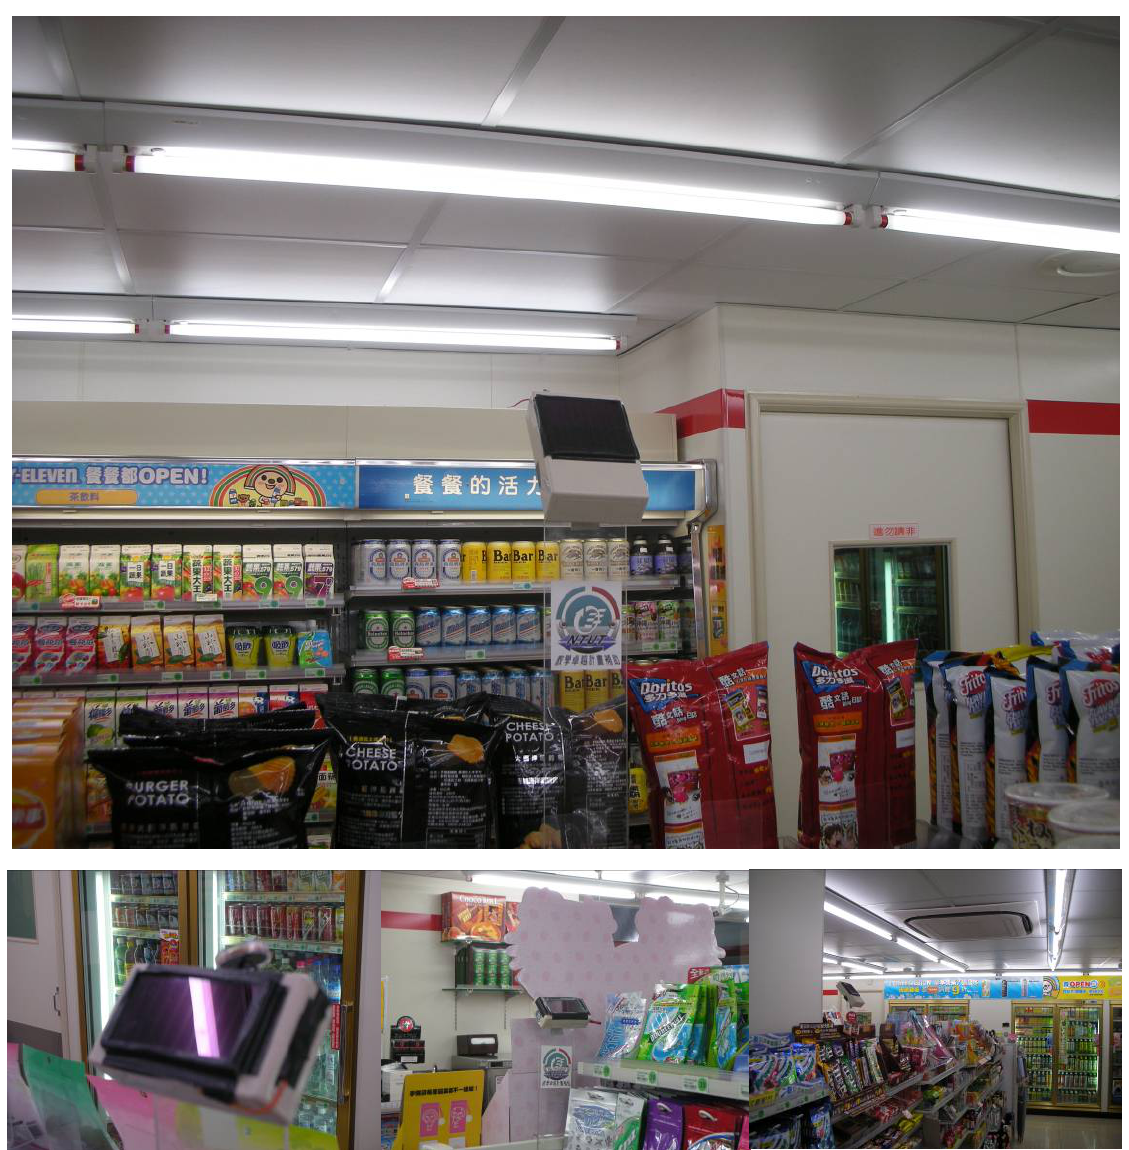
Figure 7. The energy harvesting sensor nodes deployed in a convenience store for thermal comfort measurement and optimized air conditioning